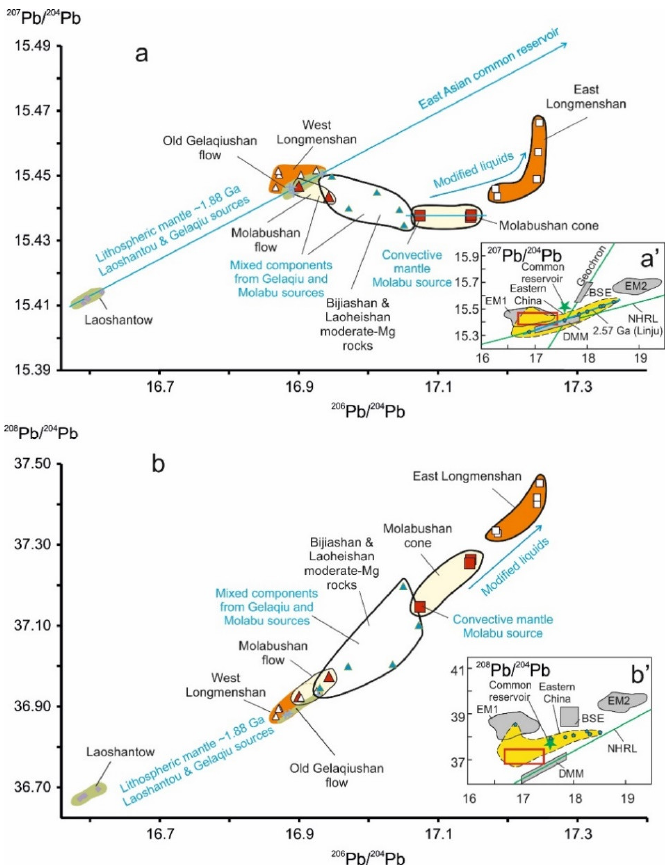
Figure 8. Diagrams of 207 Pb/ 204 Pb versus 206 Pb/ 204 Pb ratios ( a , a’ ) and 208 Pb/ 204 Pb versus 206 Pb/ 204 Pb ratios ( b , b’ ). Symbols are as in Figure 5. Calculation of the secondary isochron was performed using the Isoplot program [48]. To demonstrate mixing relations between the Gelaqiu and Molabu sources, additional data for moderate-Mg rocks from the Bijiashan and Laoheishan volcanoes [2,6] are plotted by blue triangles. Insets ( a' ) and ( b' ) indicate positions of diagrams ( a ) and ( b ) (red rectangles) relative to the whole range of East China volcanic rocks and end members of ocean basalts: DMM (Depleted MORB Mantle), EM1, EM2 (Enriched Mantle 1, 2) as well as relative to the BSE (Bulk Silicate Earth), Geochron, and NHRL [48]. The field of East China basalts and data of Pb isotopic ratios of rocks from Linju, Shandong Province are shown after [47]. The East Asian common reservoir ( 206 Pb/ 204 Pb = 17.55; 207 Pb/ 204 Pb = 15.52; 208 Pb/ 204 Pb = 37.76) is indicated after [9]. Slopes of reference lines, which approximate data points of sources, are explained in the text.